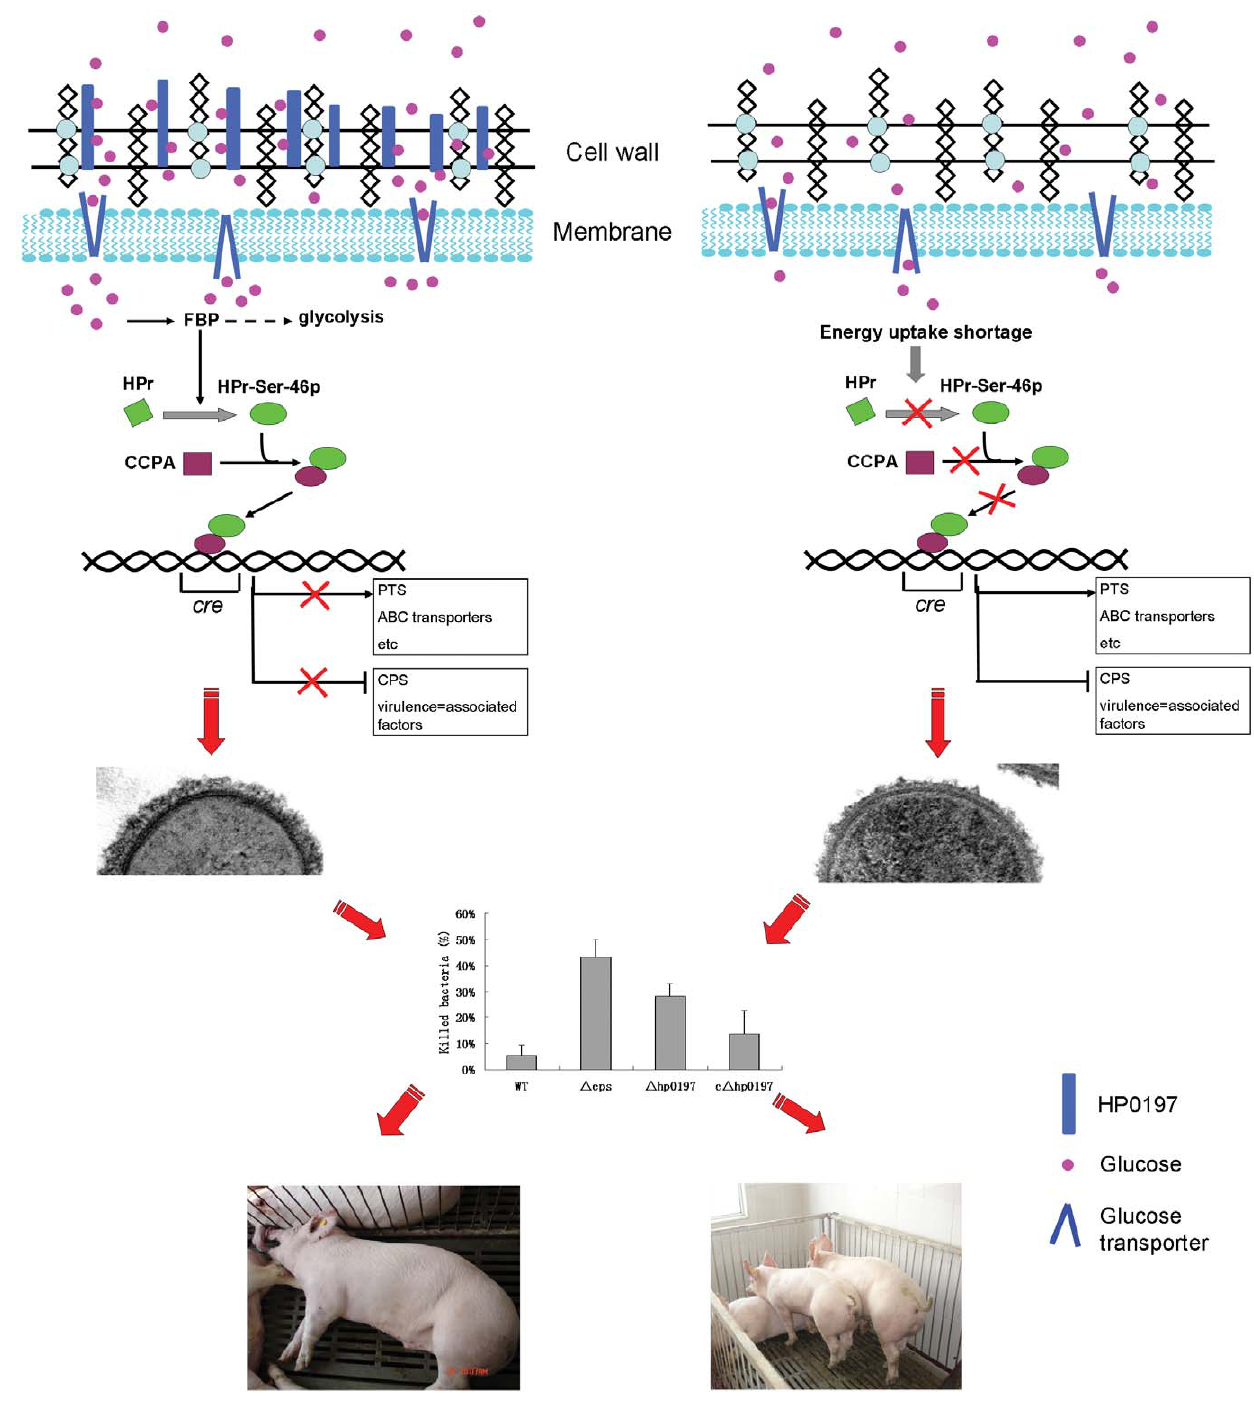
Figure 6. Schematic representation how HP0197 contributes the CPS sysnthesis and virulence of Streptococcussuis via CcpA activity. HP0197 could promote the level of phosphorylation of the phosphocarrier protein HPr at residue Ser-46 (HPr-Ser-46P), which could enhance the binding of CcpA to the cre of the target operons, subsequently control the expression of genes involved in carbohydrate utilization and CPS synthesis. A thin CPS could allow the pathogenic bacteria to be killed more easily by phagocytes and cleared from the host. Thus, HP0197 ultimately contributes to CPS synthesis and the virulence of S. suis via CcpA activity. doi:10.1371/journal.pone.0050987.g006 without assistance; 2= clearly uncoordinated or lame but able to to repeated stimuli; 3= recumbent, nonresponsive, and unaware stand without assistance; 3= severe lameness and/or severe of surroundings; and 4 =dead. Locomotion scores were given as ataxia; and 4 =dead. Pigs with a clinical score of . 2 on either follows: 0 = normal gait and posture; 1 = slight lack of co- scale were euthanized by lethal injection. The survived animals ordination, lameness, and/or joint swelling but able to stand